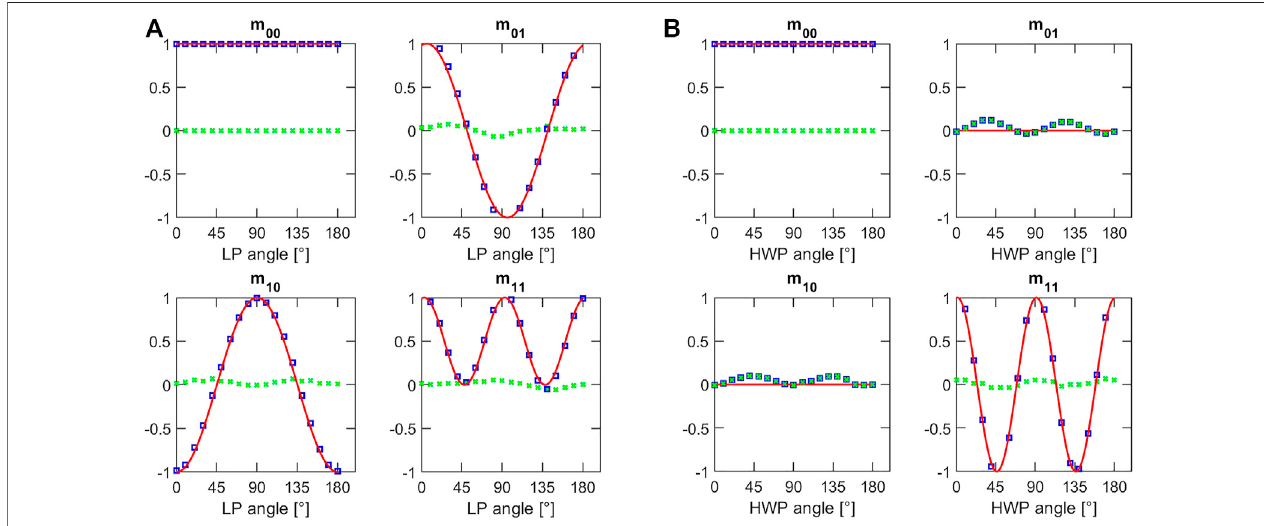
FIGURE 3 | Values of the Mueller coef fi cients as function of the azimuthal angle of (A) the linear polarizer on the left and (B) the half-wave plate on the right. Blue squaresareshowingtheexperimental results, redlines arethe fi tcurves andgreencrossesrepresent thevaluesofresidualsi.e.,thedeviationoftheexperimentalvalues with respect to the theoretical prediction.